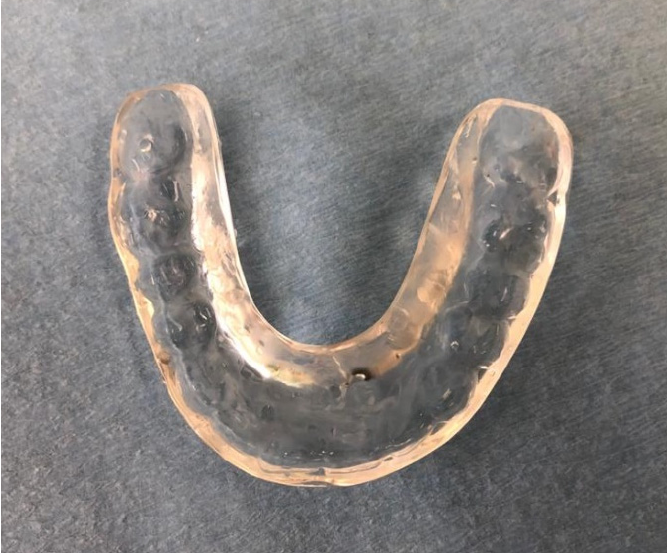
Figure 2. Occlusal splint for the management of temporomandibular disorders (TMD) and brux-